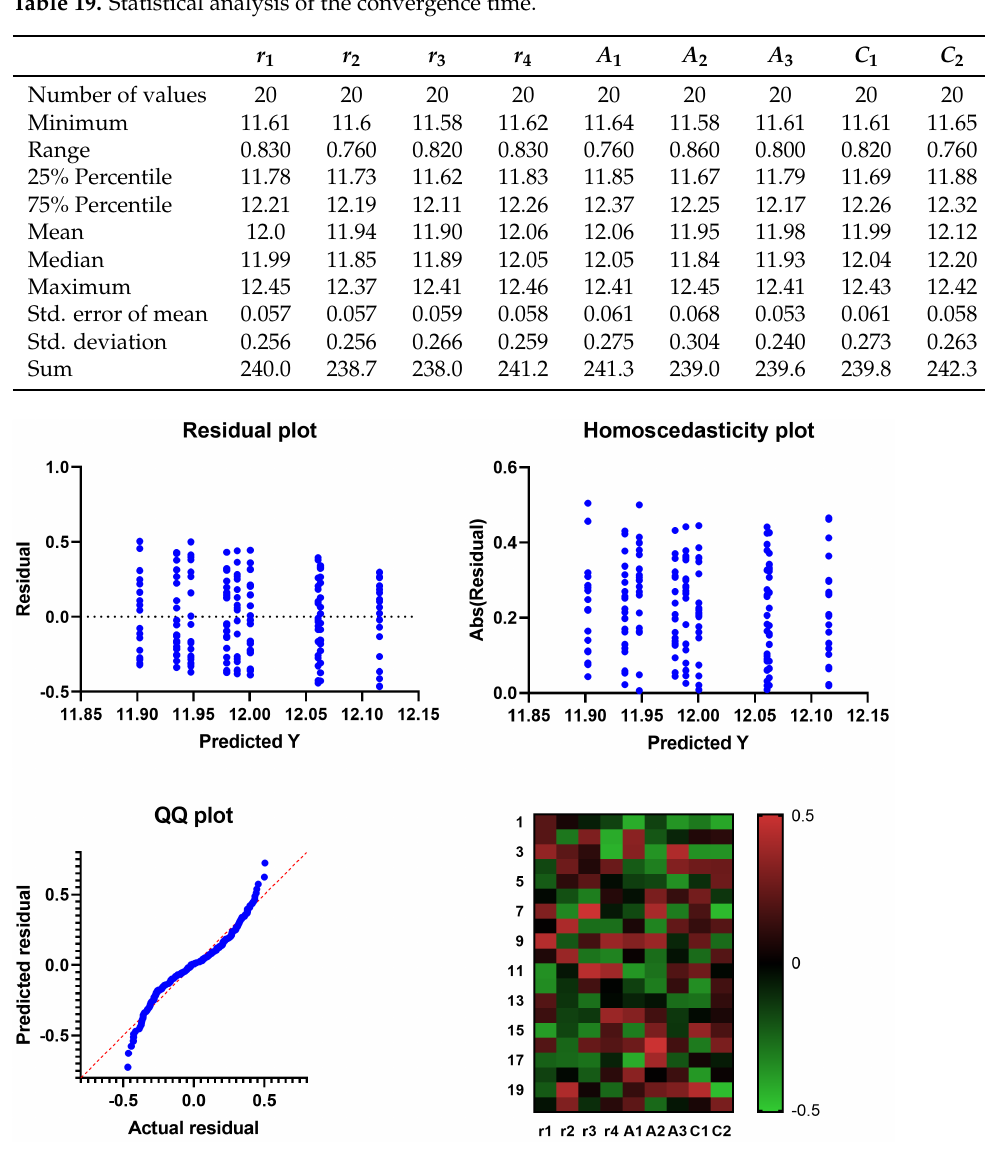
Figure 8. Residual, homoscedasticity, and QQ plots and heatmap of ADSCFGWO’s parameters ( r 1 , r 2 , r 3 , r 4 , A 1 , A 2 , A 3 , C 1 , and C 2 ) based on convergence